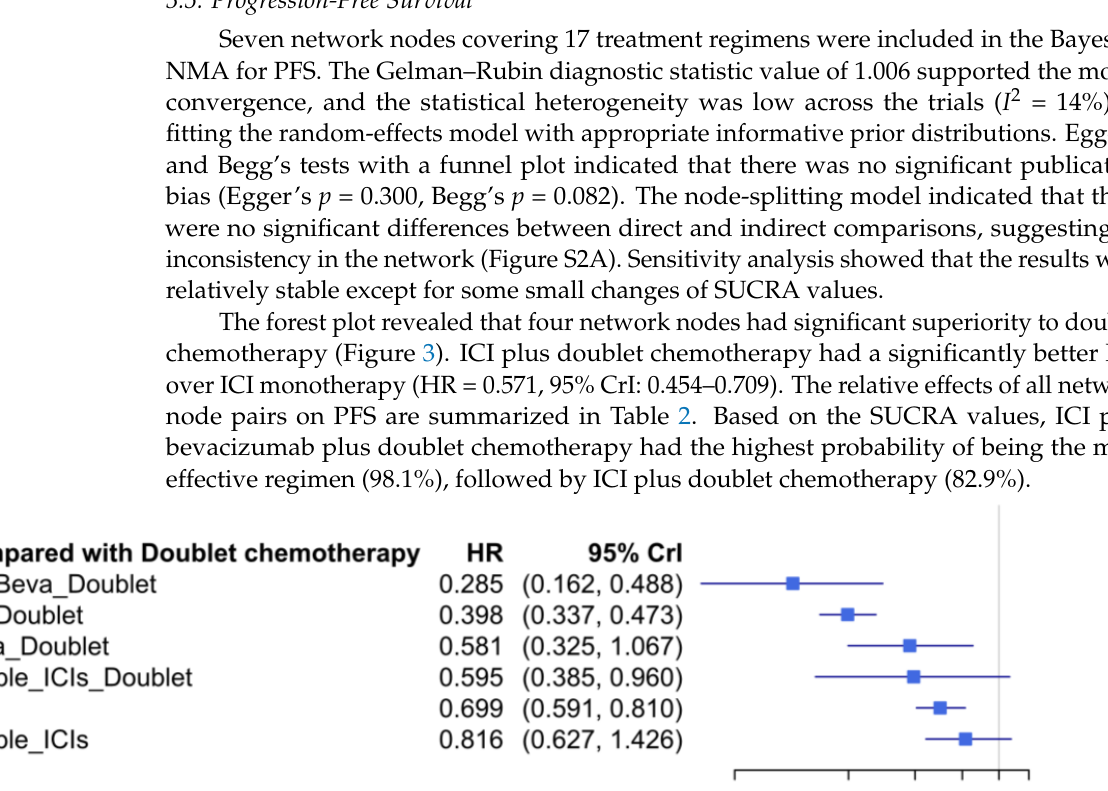
Figure 2. The network analysis diagram. Abbreviations: Beva: bevacizumab; ICI: immune checkpoint inhibitor; Doublet: doublet chemotherapy.